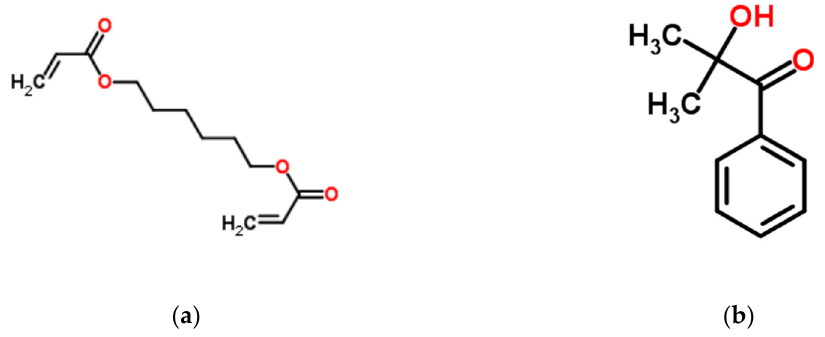
Figure 1. The chemical structures of resin components: ( a ) 1,6-hexamethylene diacrylate; ( b ) 2-